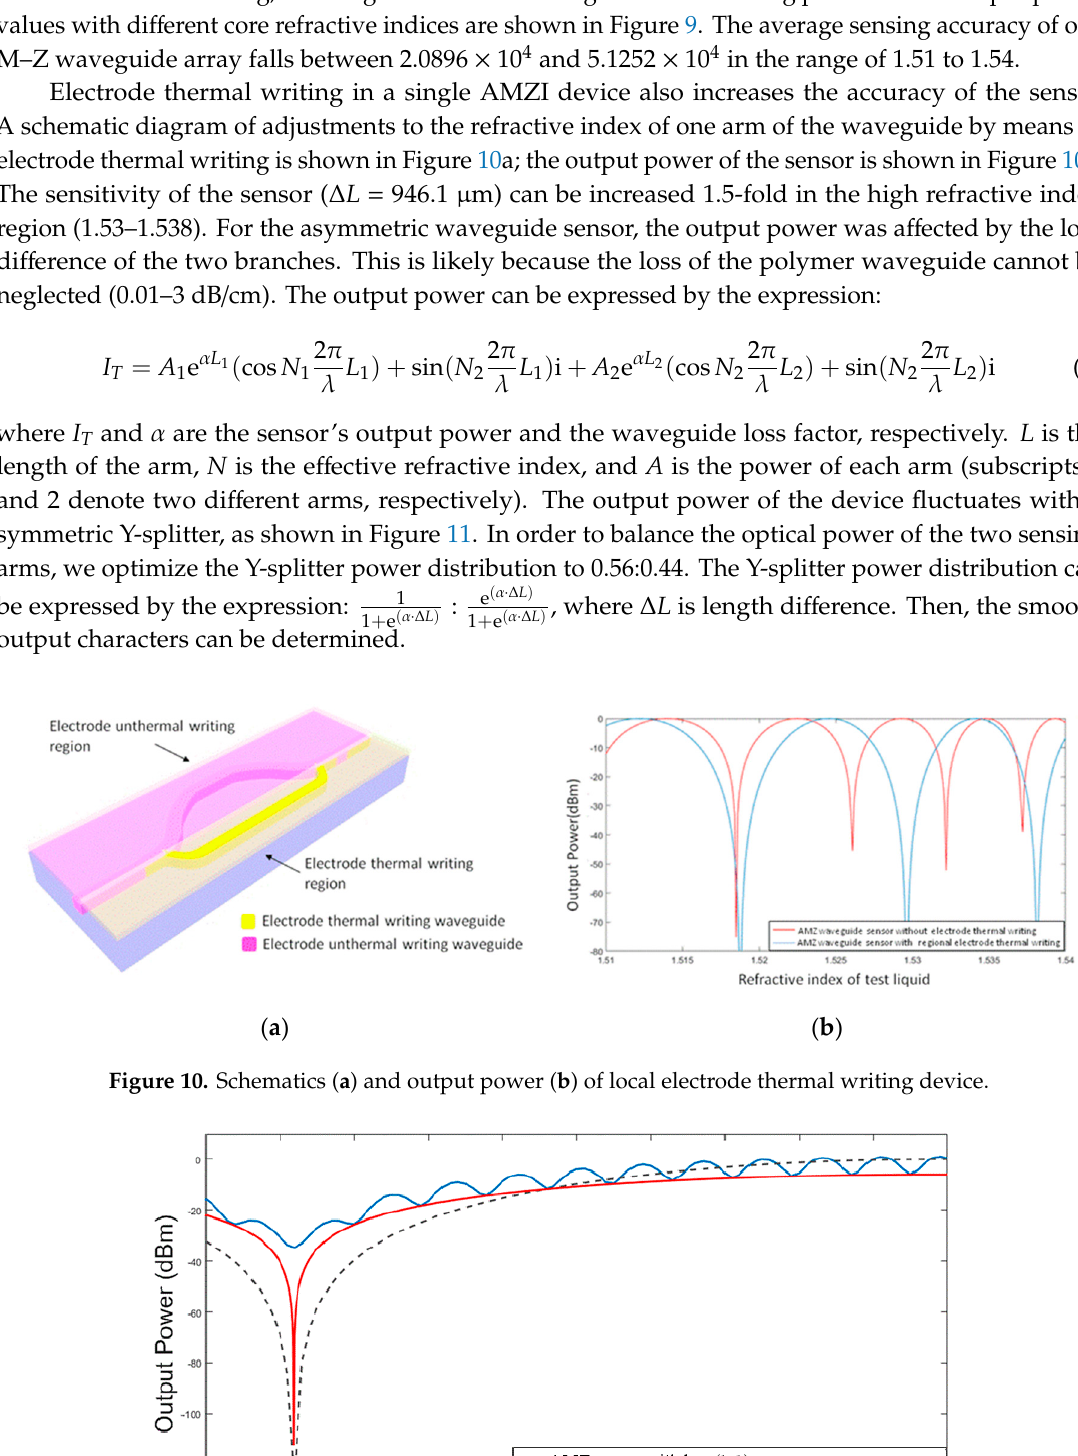
Figure 9. Transmission intensity of sensor with various length differences and core refractive indices.